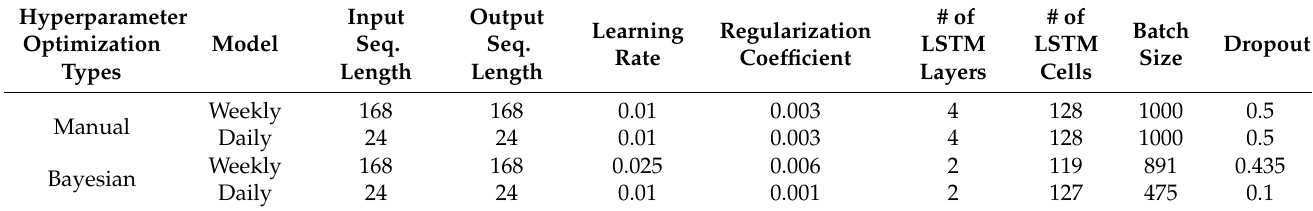
Figure 11. Load forecasting result with daily model and simulation data. Table 4. Error for test data with simulation data. Table 5. Hyperparameter values with simulation